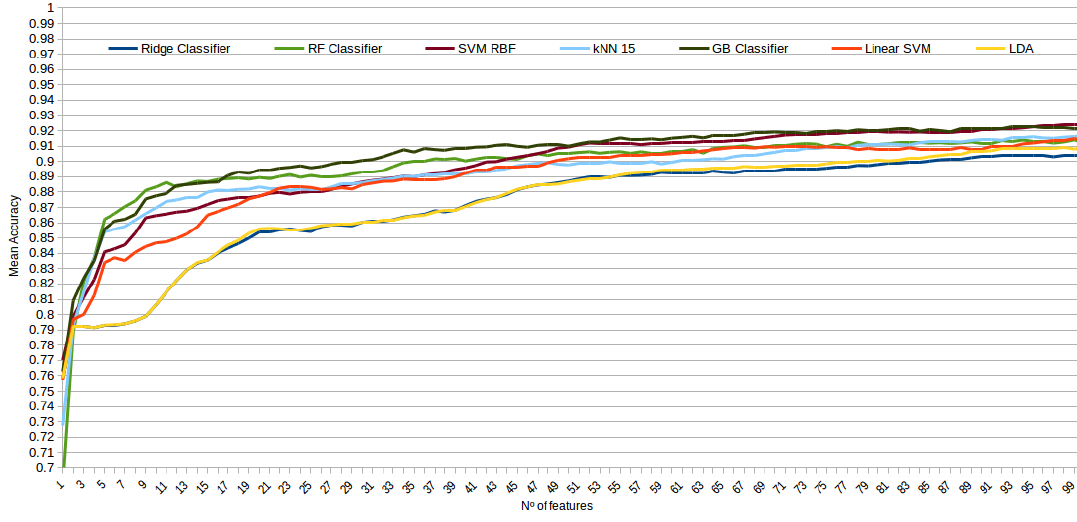
Figure 9. Evolution of the accuracy for each classifier tested with an increasing subset of features obtained with the random forest (RF) ensemble